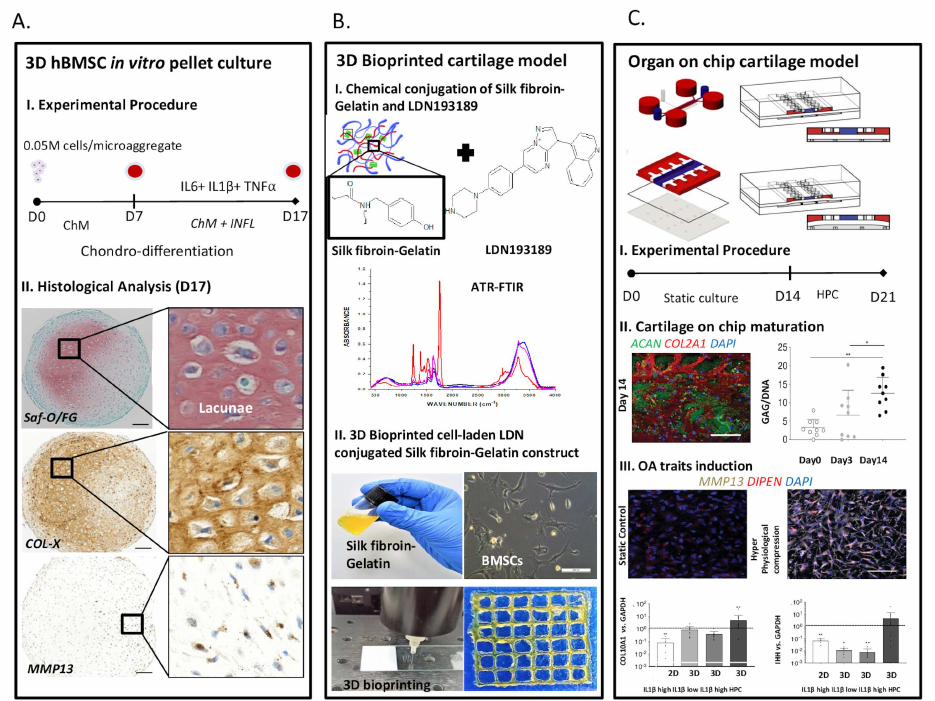
Figure 2. Strategies to recapitulate OA chondrocyte hypertrophy in possibly clinically relevant in vitro models to study the triggers leading to the phenotype and evaluate possible OA